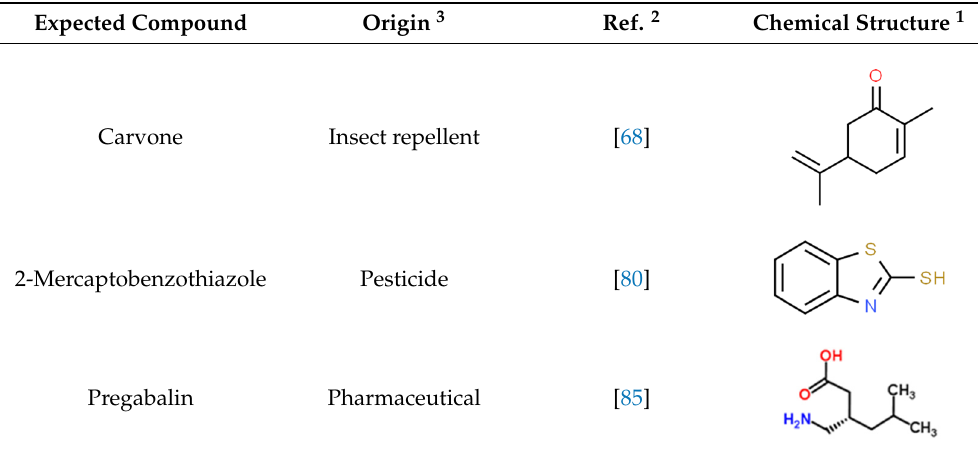
Table 5. Detected xenoestrogens in drinking water.